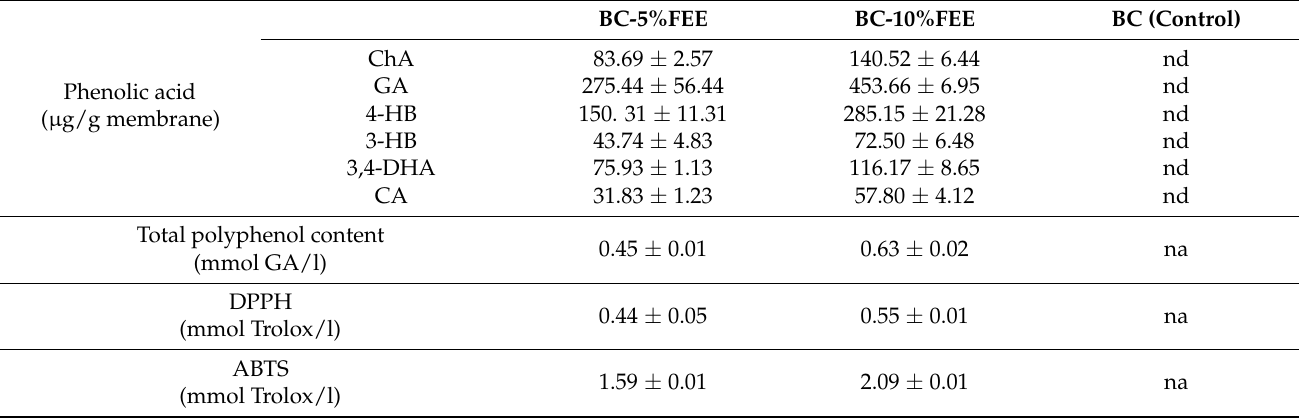
Table 3. Phenolic acid concentration, the total polyphenol content, and antioxidant activity of BC-5%FEE, BC-10%FEE, and BC. Mean ± standard deviation, n = 3.